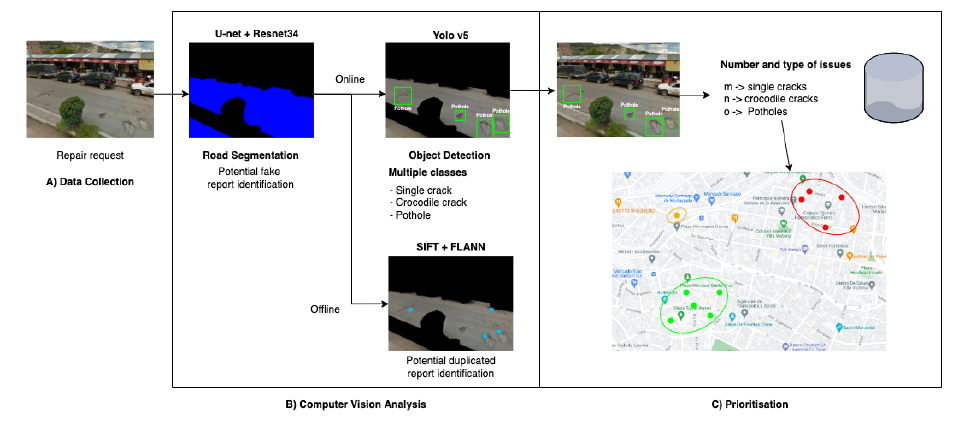
Figure 3. Proposed methodology for the automated computer-vision-based analysis of repair